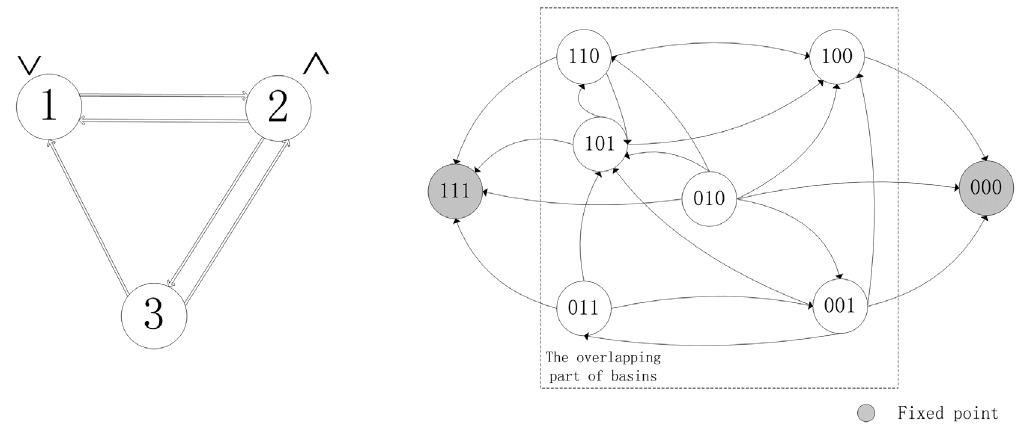
Figure 1. An asynchronous Boolean network with 3 nodes and its state space graph.